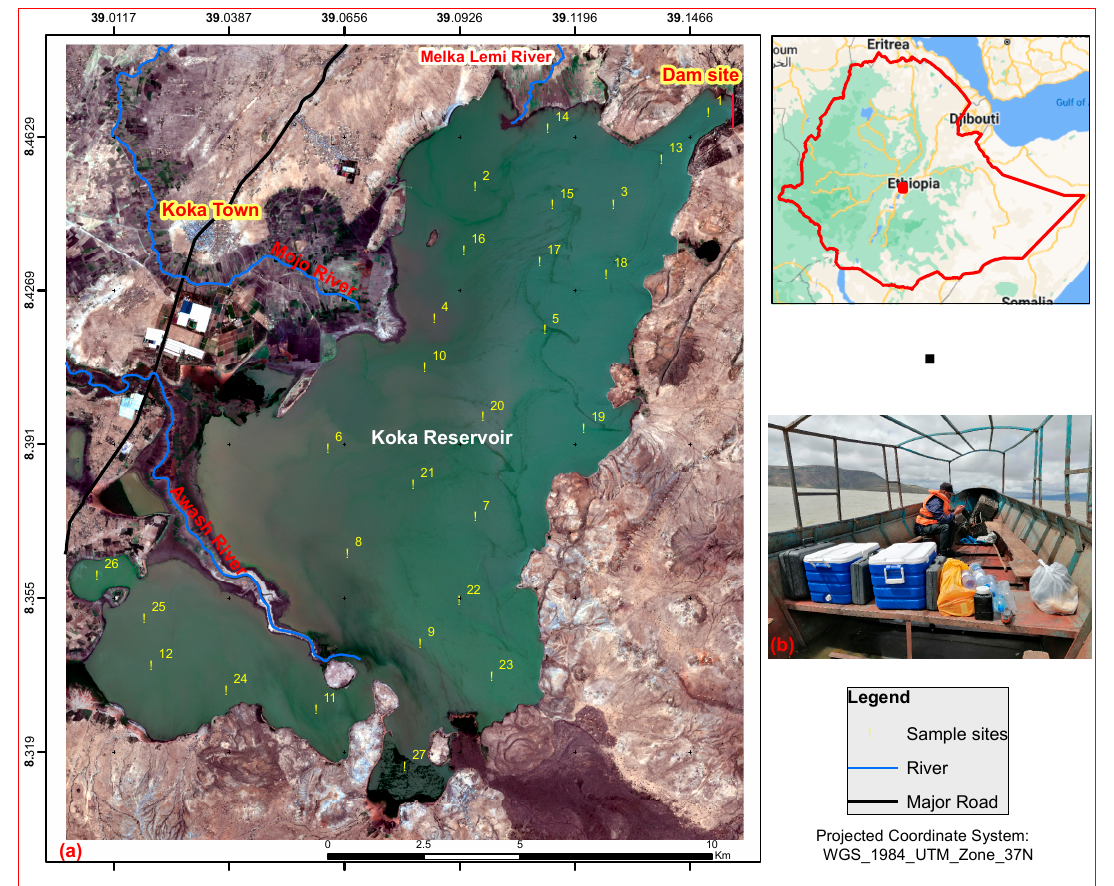
Figure 1. ( a ) Overview of the Koka reservoir with the 27 sampling locations, superimposed over a Sentinel-2 image retrieved on 20 March 2017, as surveyed with a handheld GPS receiver on a boat seen in ( b ).